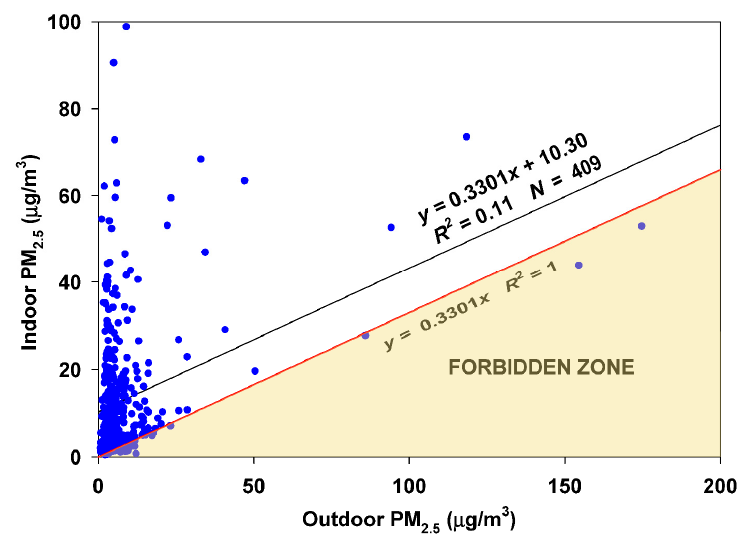
Figure 15. RCS regression of indoor on outdoor data at two nearby sites in the Outer Sunset area of San Francisco.